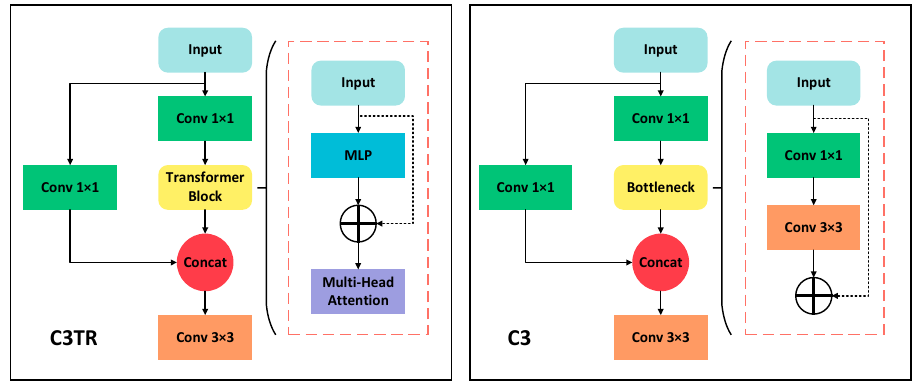
Figure 7. C3 and C3TR modules.